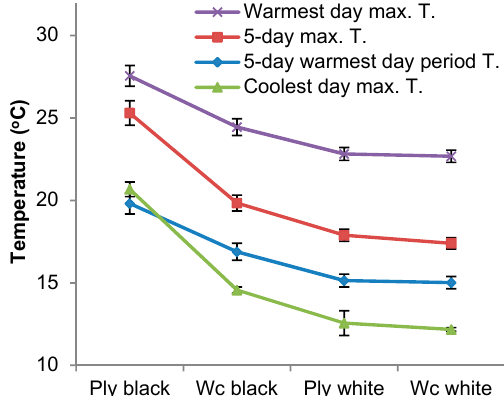
Figure 7. Summary of comparisons of front chamber mean (±se) maximum temperatures for each design (n = 4) during the periods of examination: T box_max on warmest winter day (ambient: 24.0 °C), T box_max on coolest winter day (ambient: 12.5 °C), 5-day T box_max (ambient: 18.3 °C ± 0.8) and 5-day T box_warmest (mean ambient 15.6 °C ± 0.4). ply = plywood; wc = wood-cement.